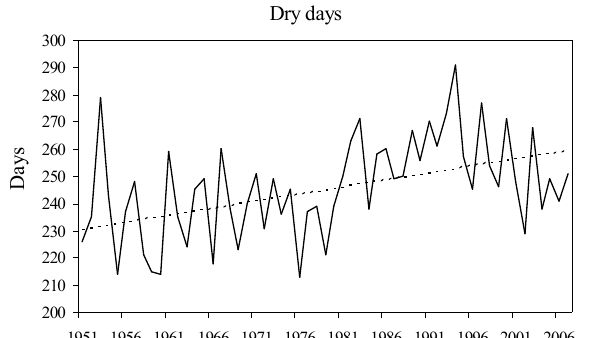
Fig. 1. Location map